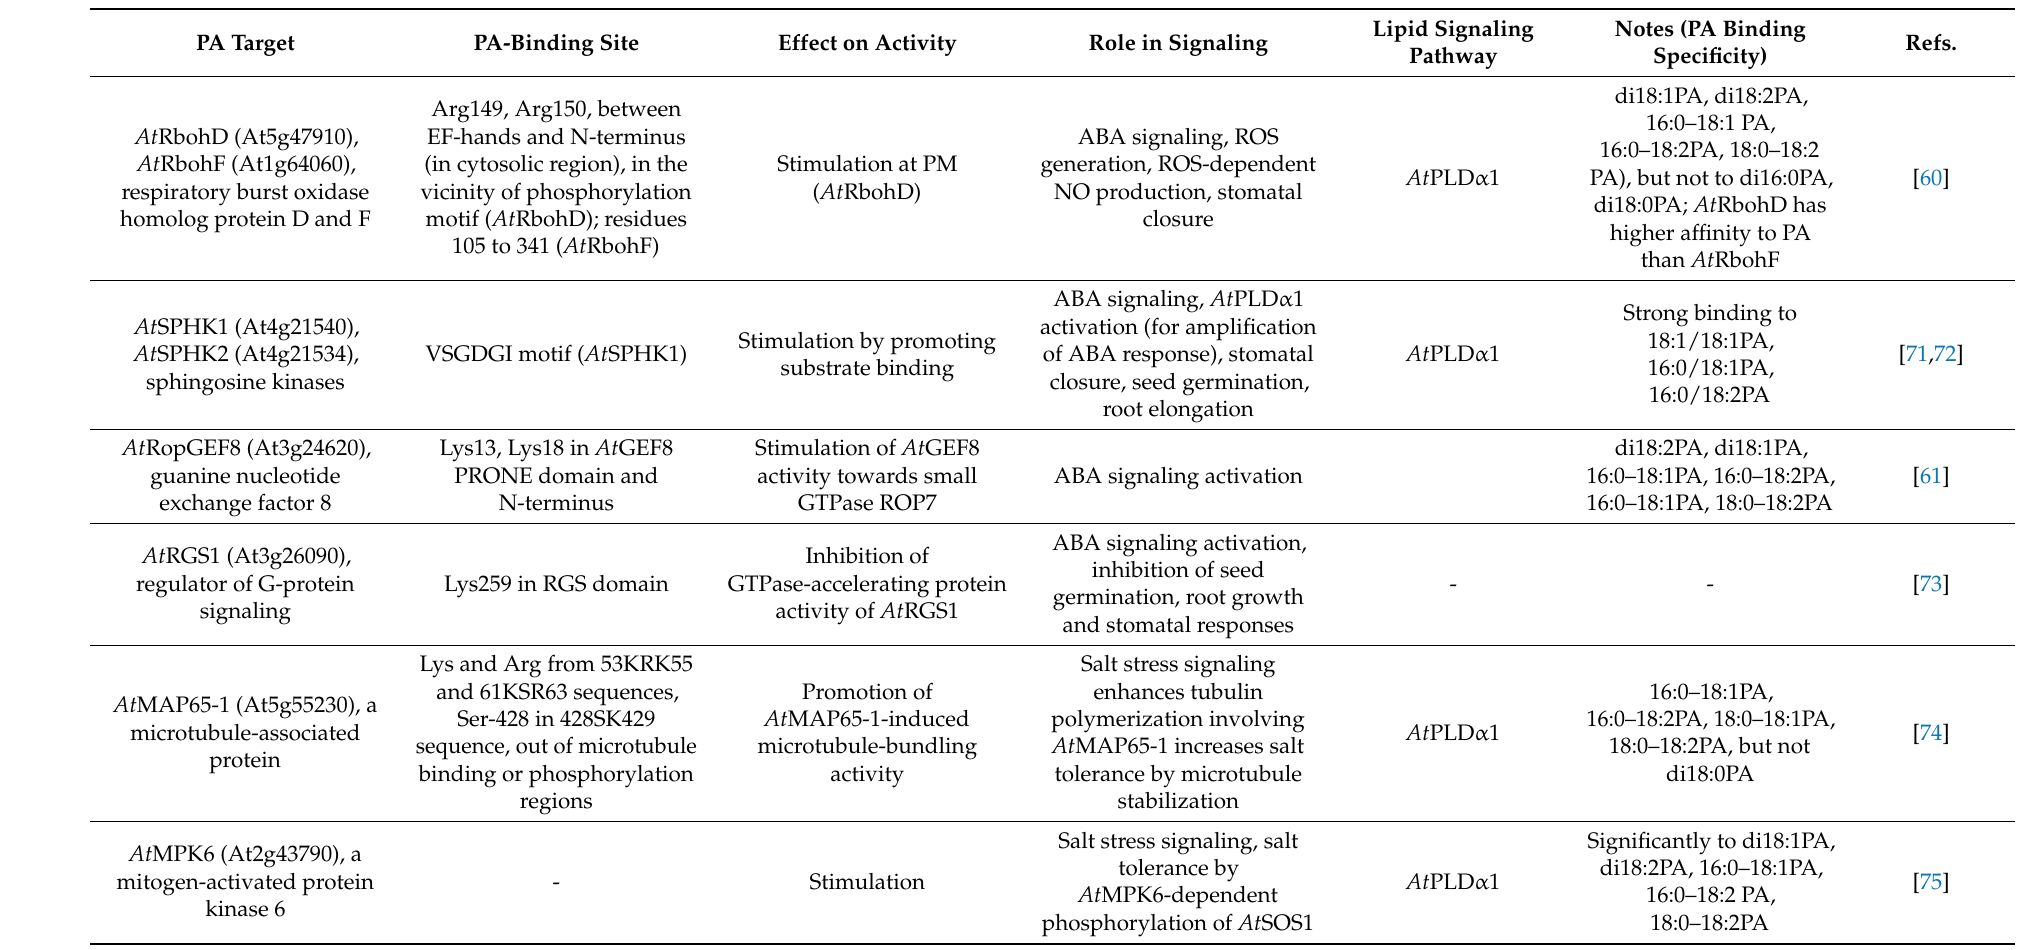
Table 1. Plant PA-binding proteins with characterized mechanism of PA binding and identified role in cell